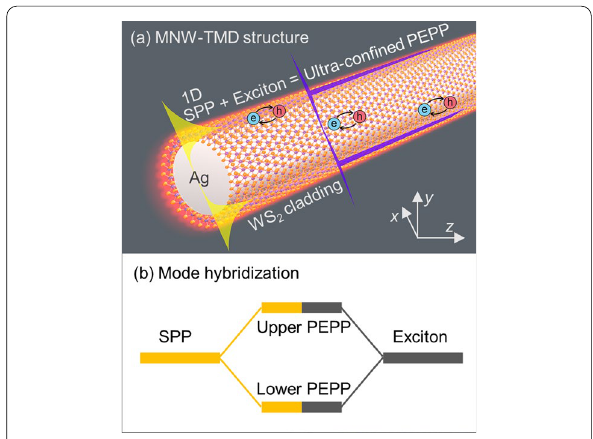
Fig. 1 a Schematic illustration of the MNW-TMD structure consisting of a Ag MNW and a monolayer WS 2 cladding. The MNW cross section is at the x – y plane, while the propagation direction is along the z axis. b Schematic illustration of the hybridization of the SPPs and